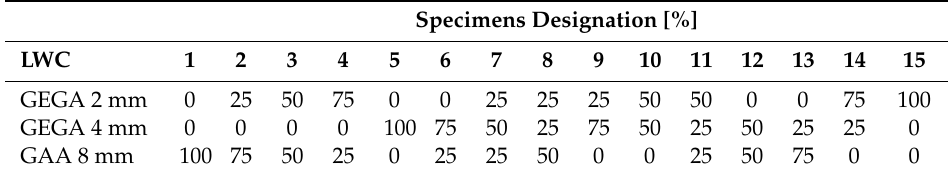
Table 4. Percentage share of the